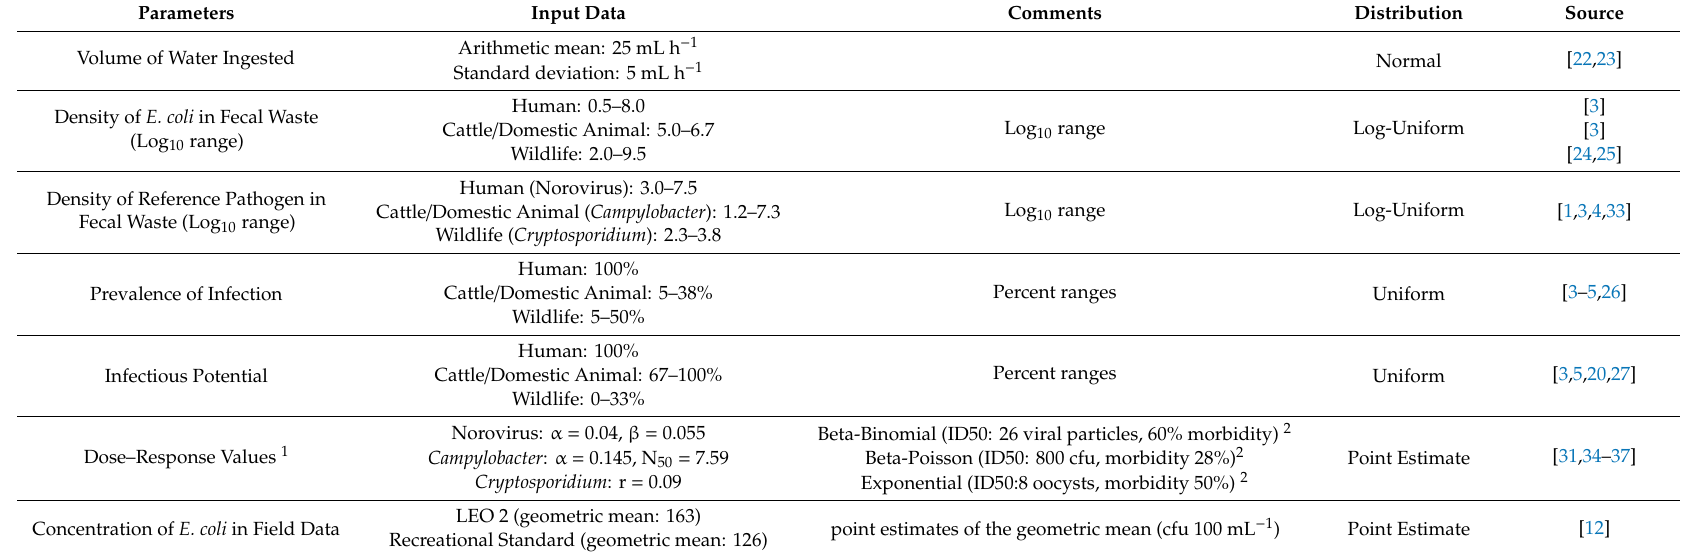
Table 1. Parameters applied for calculating the dose ingested, the risk of infection, and the risk of